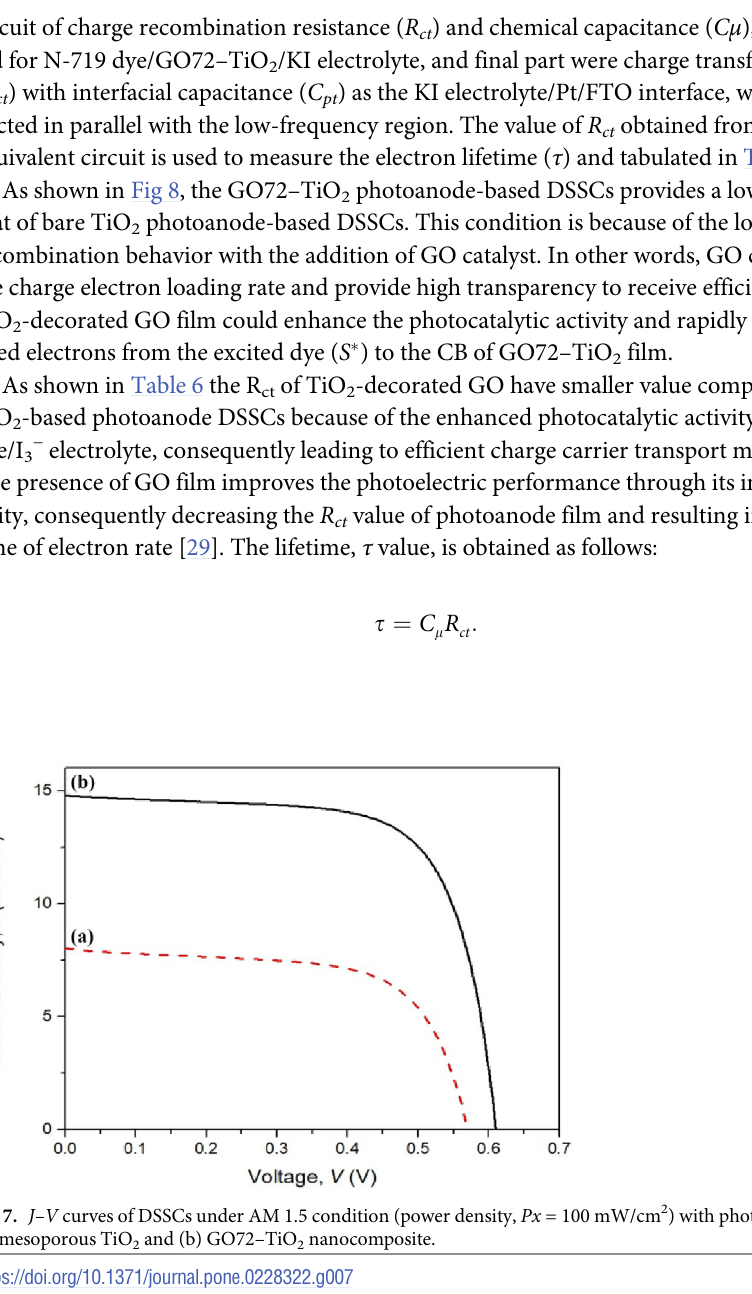
circuit of charge recombination resistance ( R ) and chemical capacitance ( Cμ ), which are fit- ct ted for N-719 dye/GO72–TiO /KI electrolyte, and final part were charge transfer resistance 2 ( R ) with interfacial capacitance ( C ) as the KI electrolyte/Pt/FTO interface, which is con- ct pt nected in parallel with the low-frequency region. The value of R obtained from the fitted ct equivalent circuit is used to measure the electron lifetime ( τ ) and tabulated in Table 6.